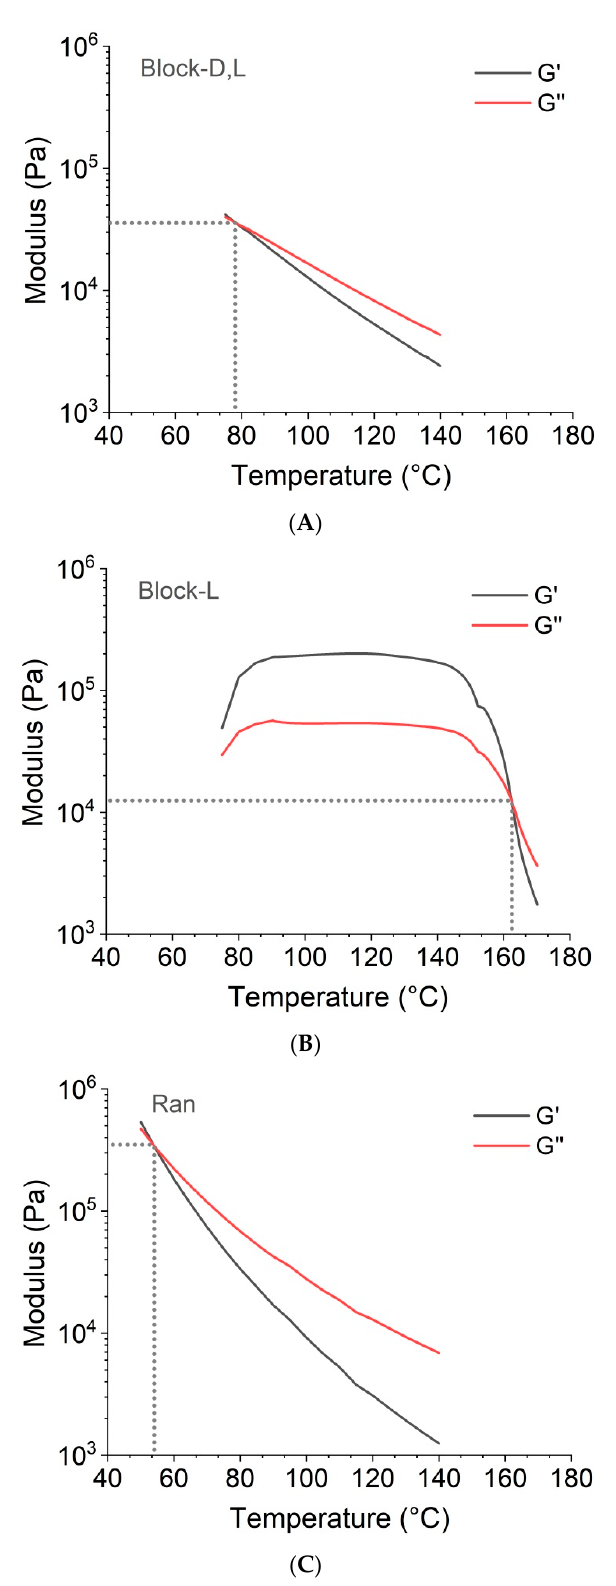
Figure 6. Evolution of the elastic (G’) and viscous (G’’) moduli as a function of temperature (Isochronal tests) carried out at 1 Hz of frequency and 0.1% of strain for ( A ) Block-D,L, ( B ) Block-L and ( C ) Ran samples.